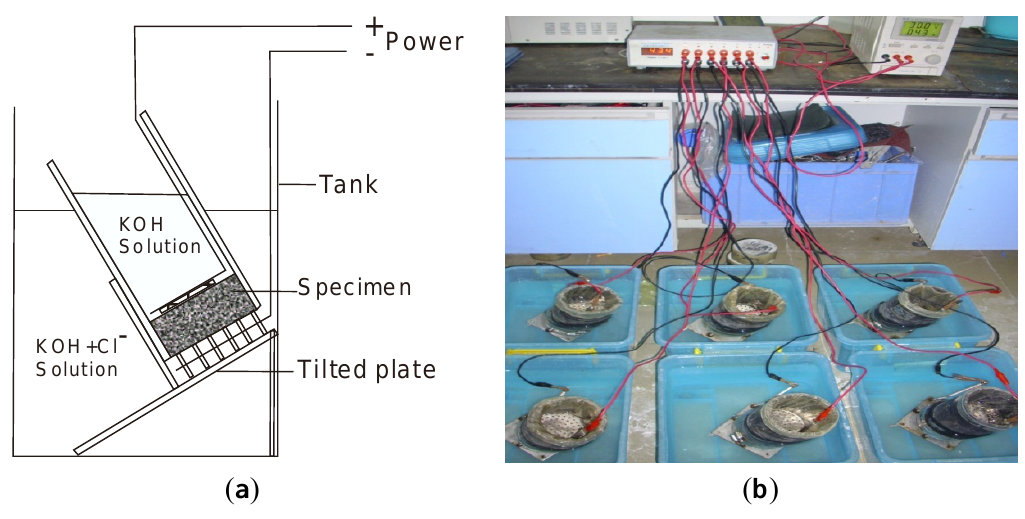
Figure 10. Specimen colored by AgNO